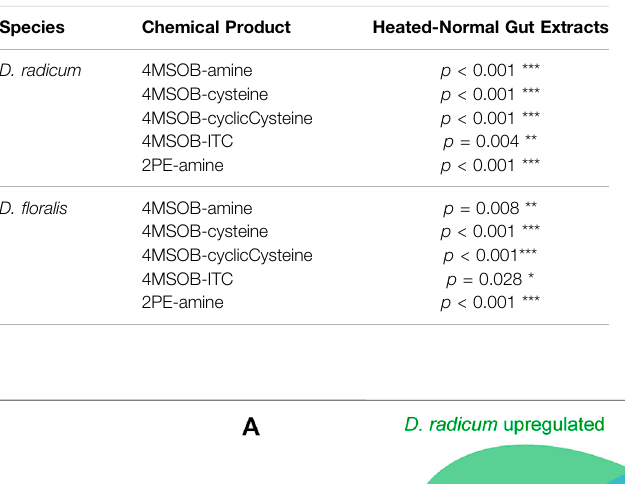
TABLE 2 | One-way ANOVA followed by Tukey post-hoc of the contents of isothiocyanate (ITC) and derived products in normal and heated gut extracts from Delia radicum or D. fl oralis larvae incubated with 4-(methylsul fi nyl)butyl (4MSOB) or 2-phenylethyl (2PE) isothiocyanate. Each condition was presented by three replicates consisting of a pool of 10 larval guts.